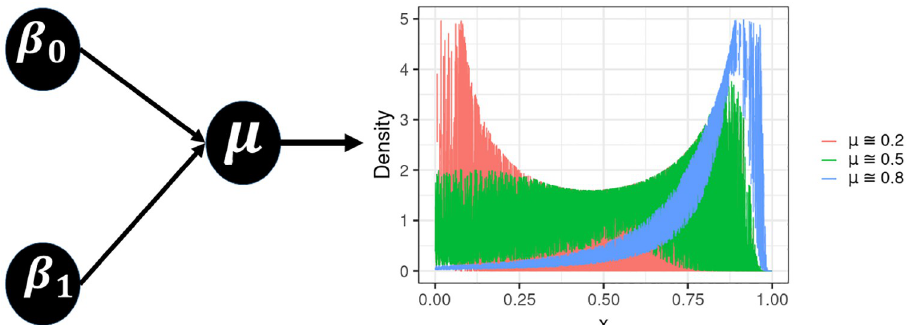
Fig 3. General description of the UL density function, followed by its illustration in different locations conditioned to the process mean parameter ( μ ).